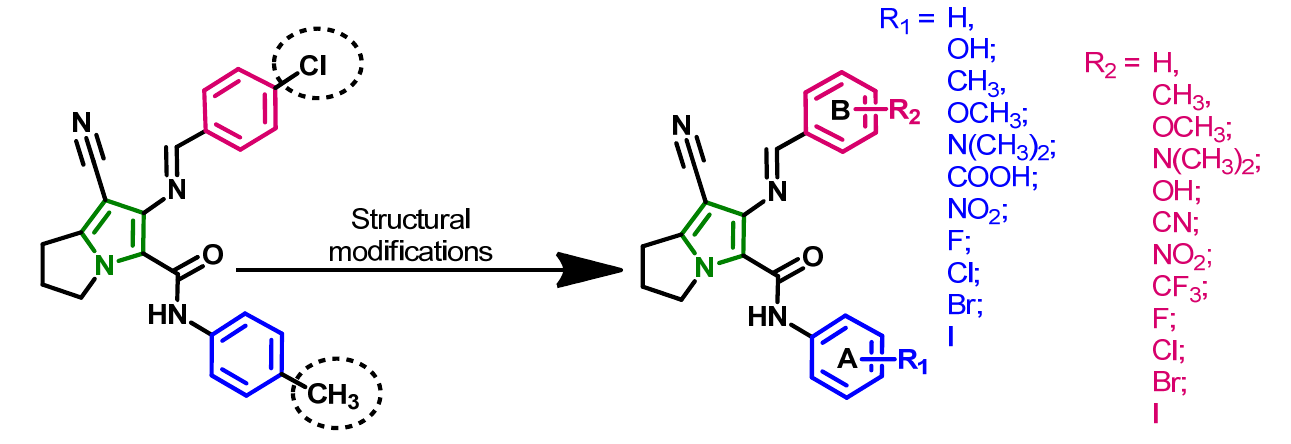
Figure 3. Structural modifications of compound 10 .